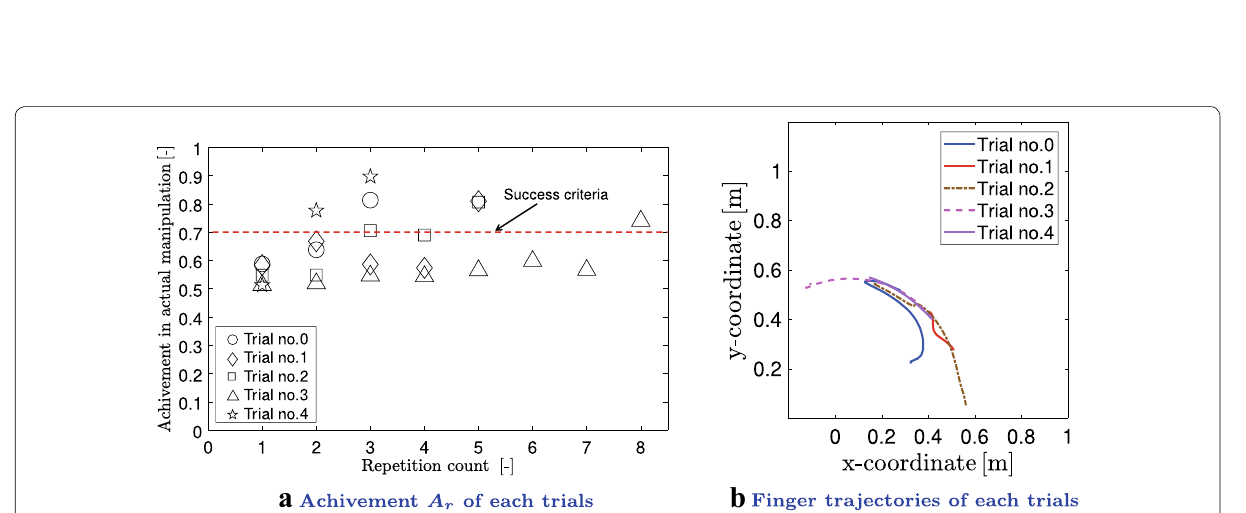
Fig. 22 Reproducibility of manipulation (desired image of string shape: J)